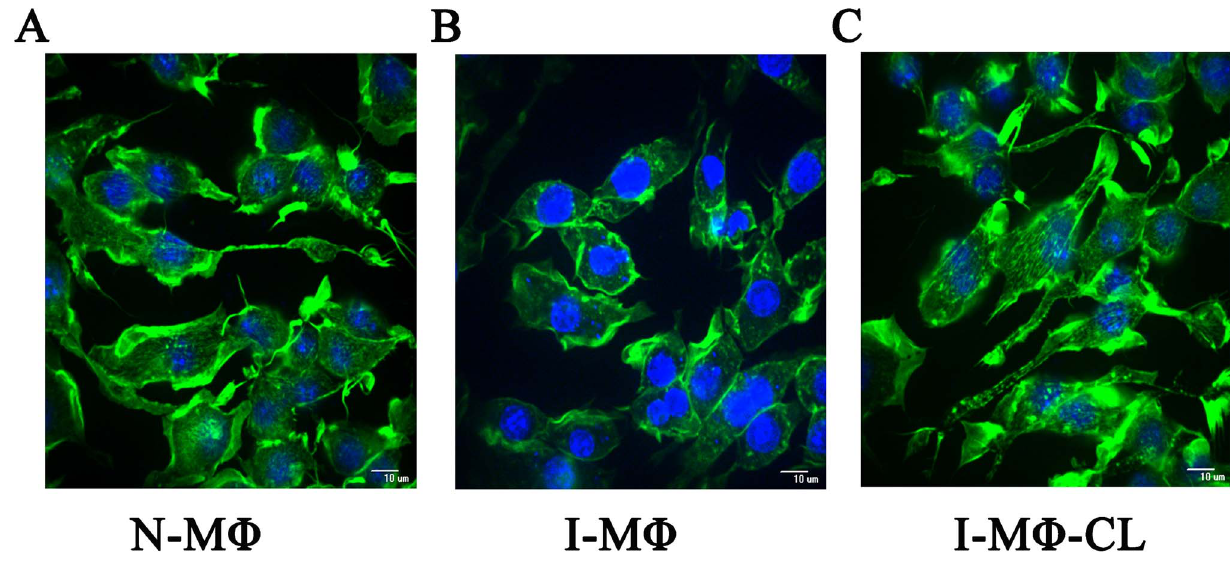
Figure 6. Alteration in actin cytoskeleton. The actin cytoskeleton change was determined by staining with alex488 conjugated phalloidin (green). Phalloidin binds to F-actin. The nucleus and parasite was stained with DAPI (blue) and visualized by confocal microscopy. A) N-M W , B) I-M W , and C) I-M W -CL.